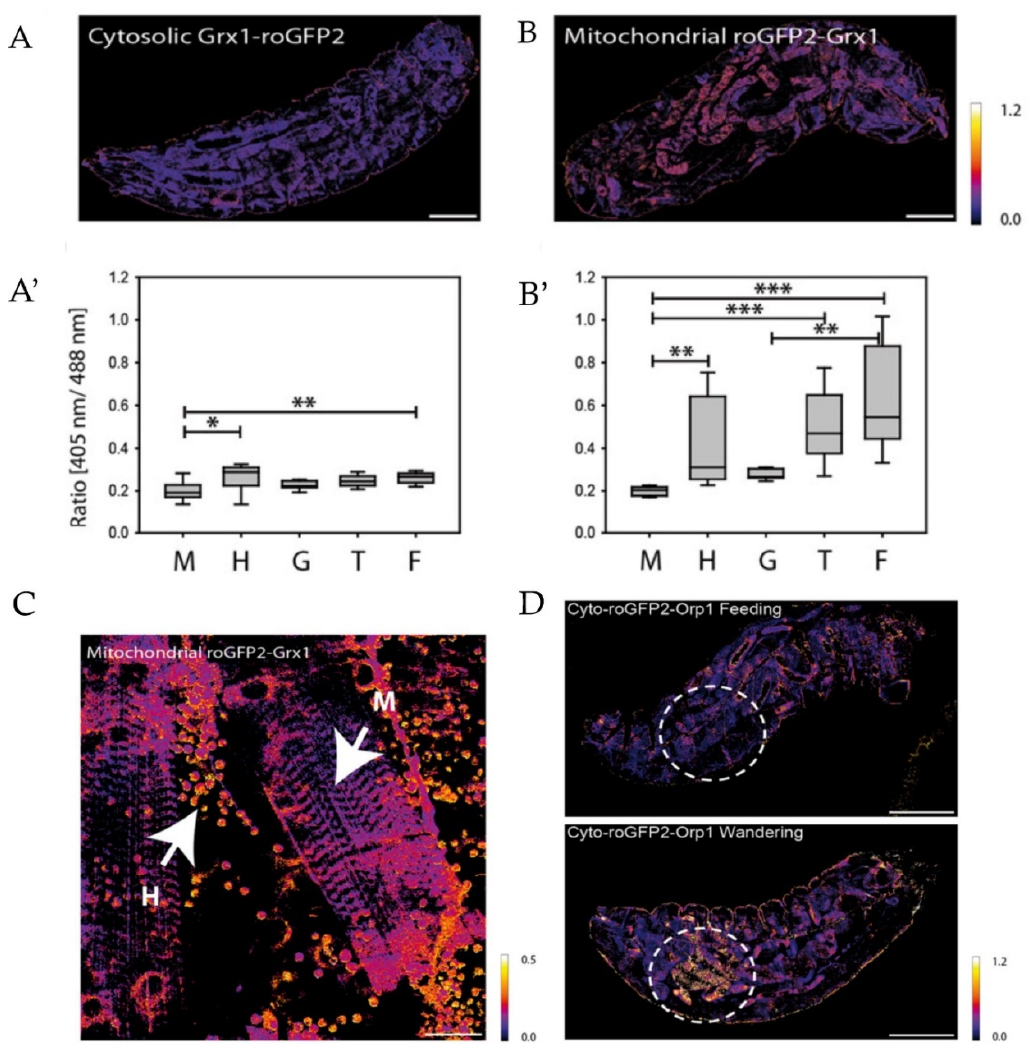
Figure 1. ( A,B ) Ratio images of whole intact larvae expressing cyto-Grx1-roGFP2 ( A ), mito-roGFP2-Grx1 ( B ). Probe responses in selected tissues were quantified in ten individual third-instar larvae for each biosensor ( A’,B’ ). Boxes, lower/upper quartile; whiskers, 5th/95th percentile. * p < 0.05, ** p < 0.01, *** p < 0.001. M, muscle; H, hemocytes; G, gut; T, (Malpighian) tubules; F, fat. Scale bars, 600 µm. ( C ) A representative detailed image to highlight tissue-specific differences evident in mito-roGFP2-Grx1-expressing larvae. Arrows indicate hemocytes (H) and muscle tissue (M). Scale bar, 60 µm. ( D ) Feeding (top) and wandering (bottom) third-instar larvae expressing the cytosolic roGFP2-Orp1 probe. Scale bars, 600 µm. Reprinted by permission from Elsevier: Cell Metabolism [18], copyright 2011.